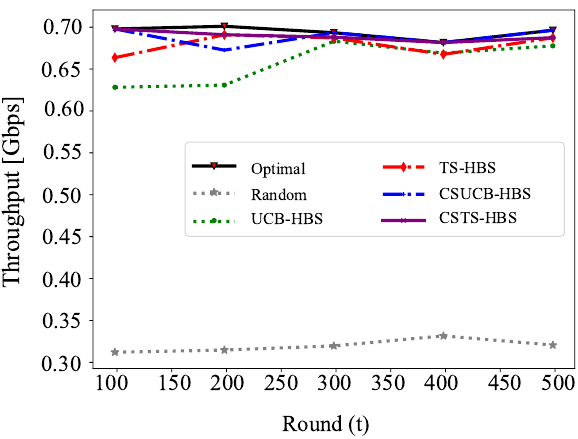
Figure 5. Convergence Rate